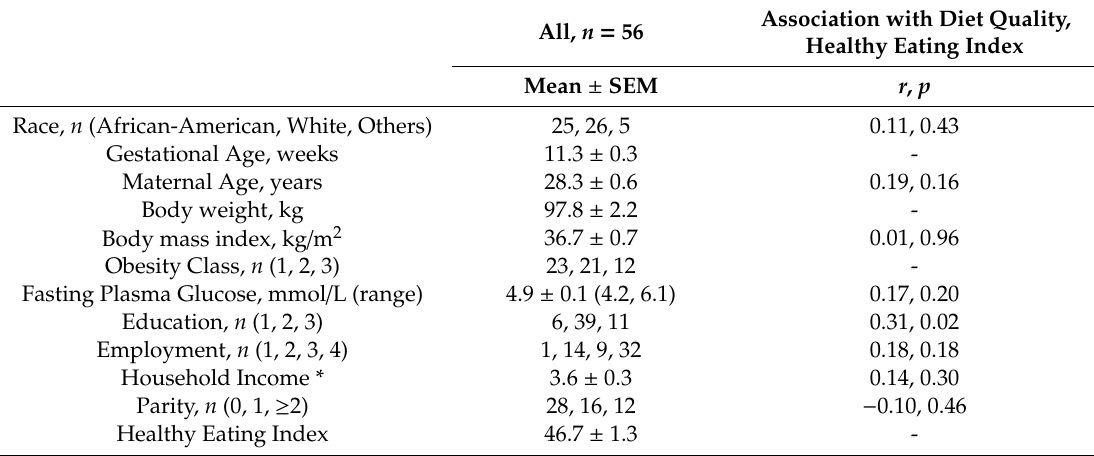
Table 1. Subject Characteristics. All, n =